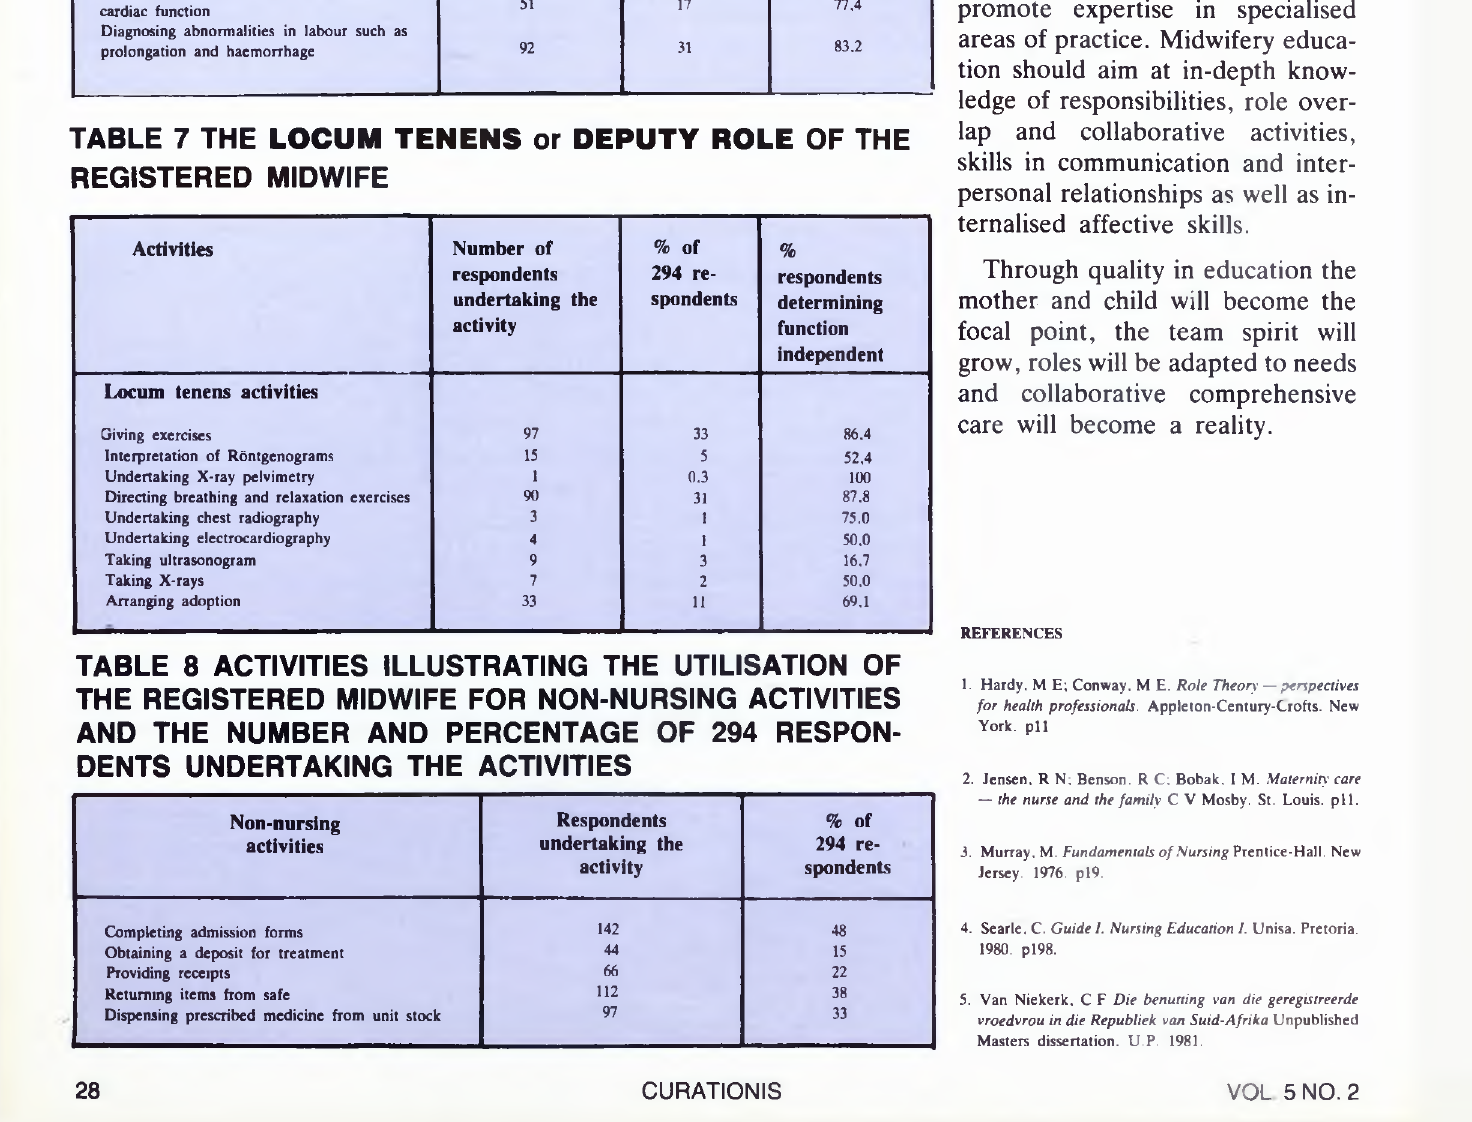
TABLE 7 THE LOCUM TENENS or DEPUTY ROLE OF THE REGISTERED MIDWIFE